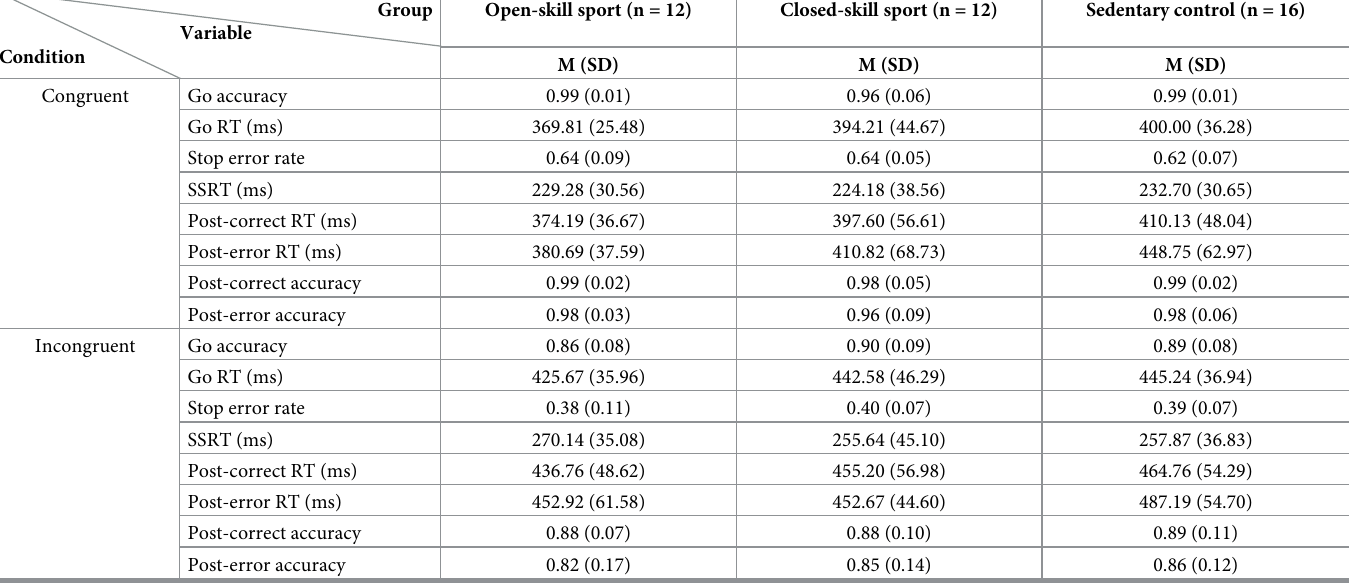
Table 2. Descriptive statistics of behavioral performance across groups and